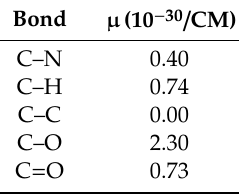
Table 4. Dipole moments of the chemical bonds of the relevant molecules expressed in Debye units